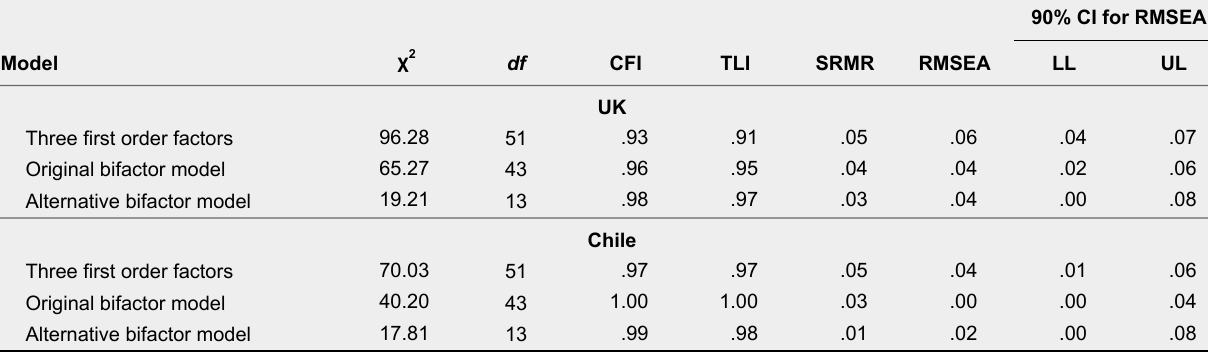
Model Fit Statistics and Close-Fit Indices Associated With CFA Models by